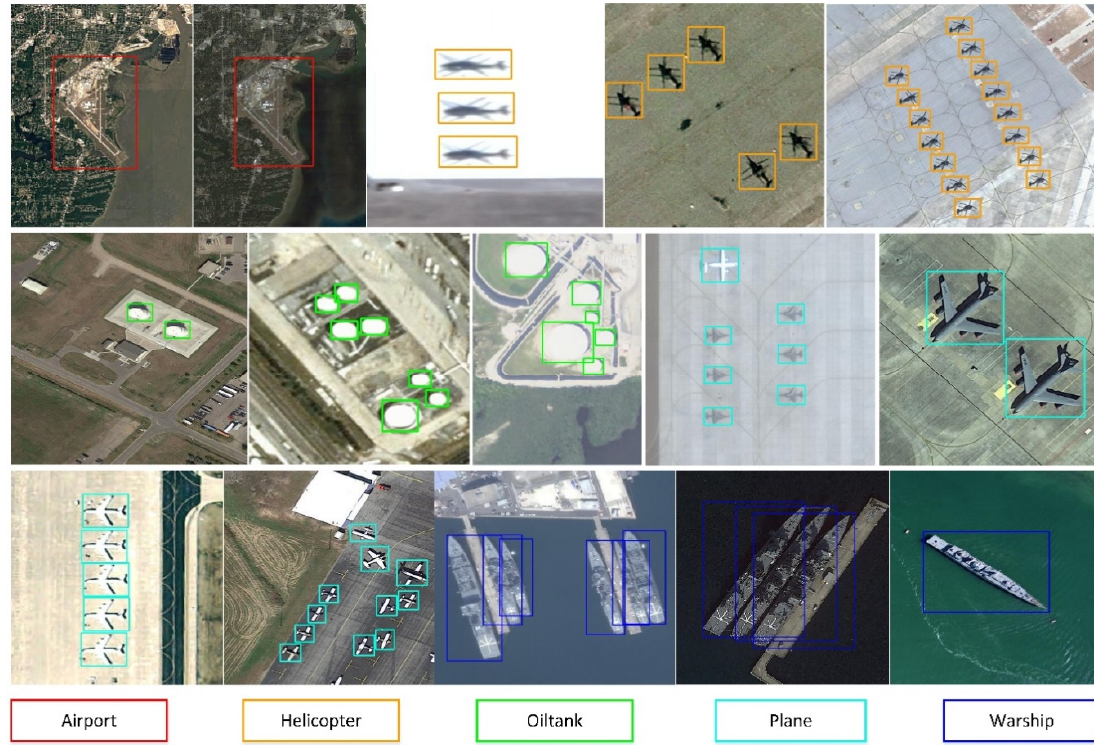
Figure 1. Example images and annotated bounding boxes of the remote-sensing dataset for geospatial object detection (RSD-GOD). There are 5 classical geospatial categories, including airport, helicopter, oiltank, plane, and warship. Different object categories are indicated by different color rectangles.